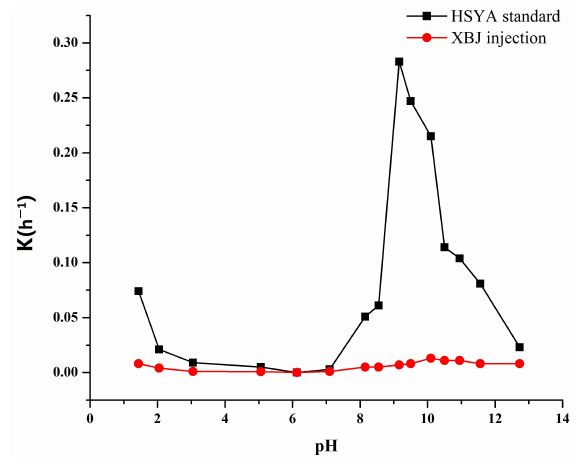
Figure 3. pH profile of k of HSYA degradation at 25 °C in aqueous solution and XBJ injection. Table 1. Kinetic parameters of the hydrolysis of HSYA at 25 °C.